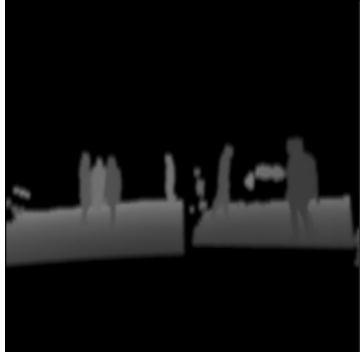
Figure 18. The 3D lidar pointcloud is projected into a 2D grayscale image with 16-bit